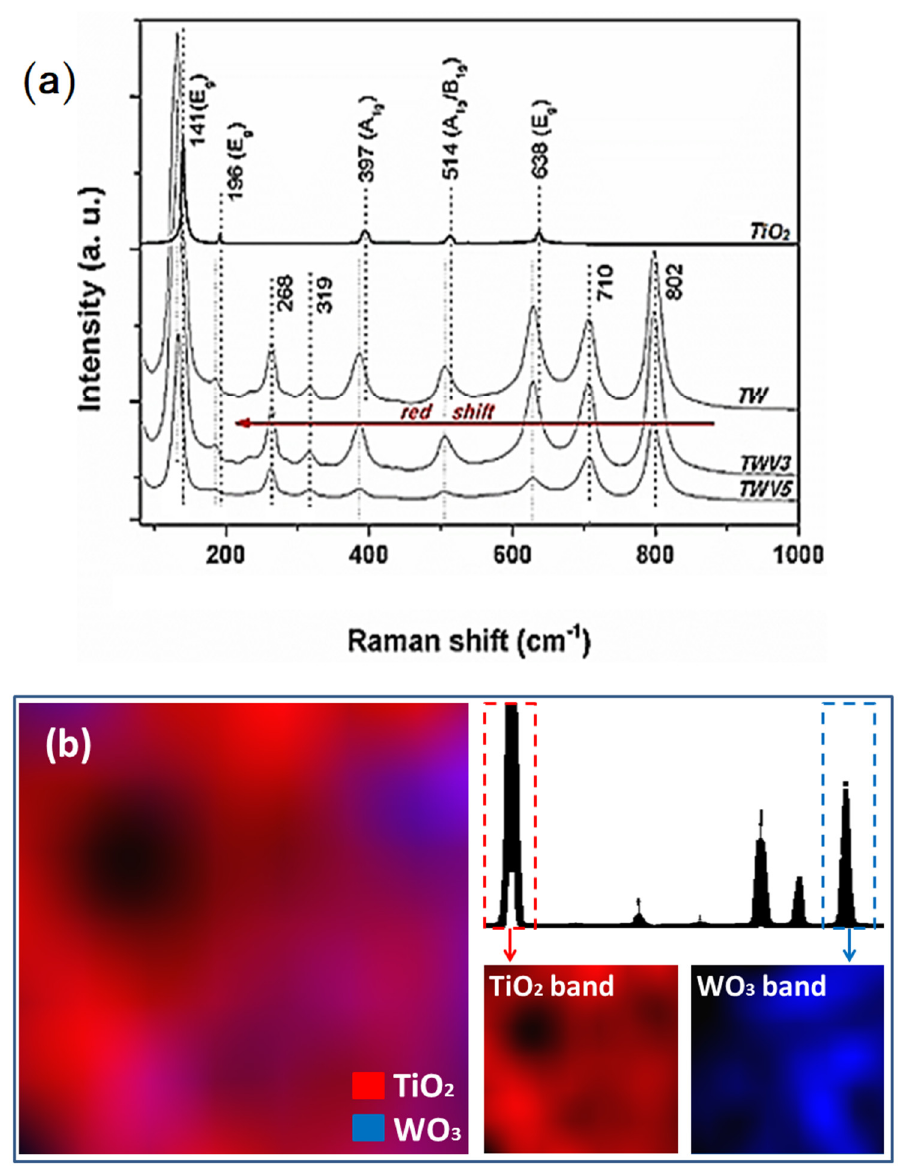
Figure 2. ( a ) Raman spectra of the metal oxide nanocomposites compared to pristine anatase TiO 2 ; ( b ) representative Raman mapping of MON samples, with indication of TiO 2 and WO 3 vibra- tional bands.